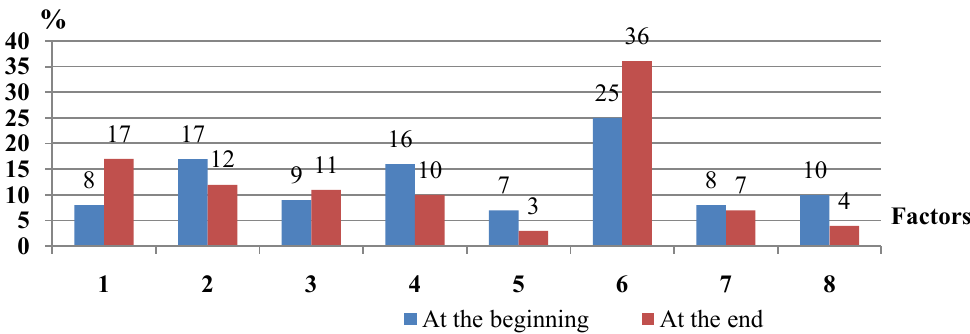
Fig.6. Factors of school anxiety of girls with kyphotic postures during academic year (n=21): 1-8 see